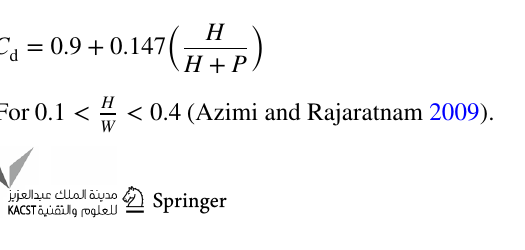
Fig. 4 The stepped weir levels using the QGIS program,